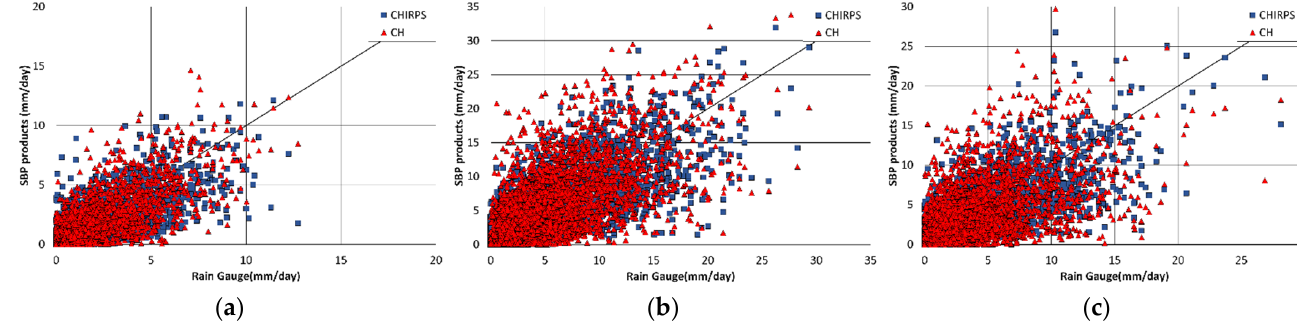
Figure 8. Daily scatter plots of the SBP products for the: ( a ) Altiplano, ( b ) Amazon and ( c ) La Plata basins.